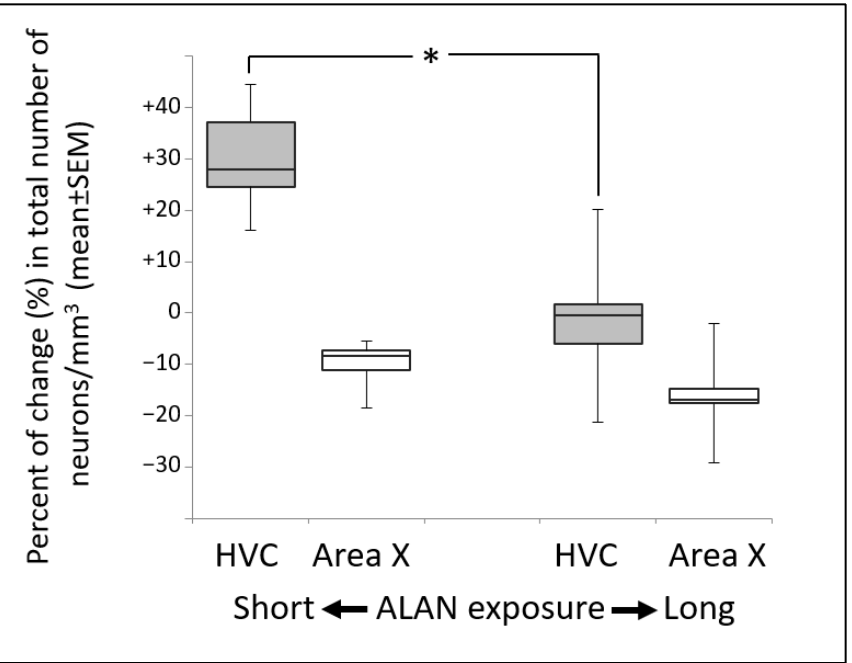
Figure 8. Total neuronal densities (adjusted to controls; number of neurons/mm 3 mean±SE) in HVC and Area X, in brains of birds exposed to short (three weeks) and long (six weeks) term 5lux ALAN. *—indicates a significant difference of p < 0.0001; Tukey post hoc tests following one-way ANOVAs for each brain region separately. n = 8 birds/group.